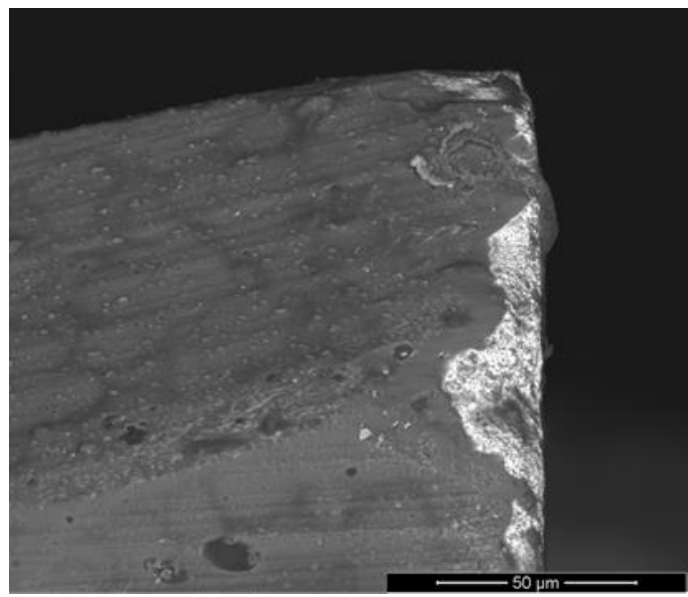
Figure 12. Abrasive wear on the clearance face of T2L4F125 tool.